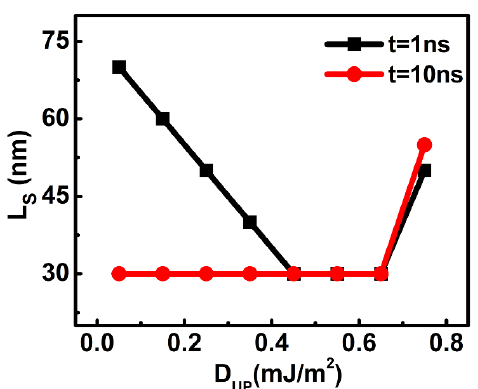
Figure 6. The length of the staggered domain region as a function of the DMI constant of the upper layer at different times. (The K U and K L were fixed as 2.5 × 10 5 J/m 3 and 5 × 10 5 J/m 3 , and J ex = −0.15 mJ/m 2 , and D L = 0.75 mJ/m 2 .).